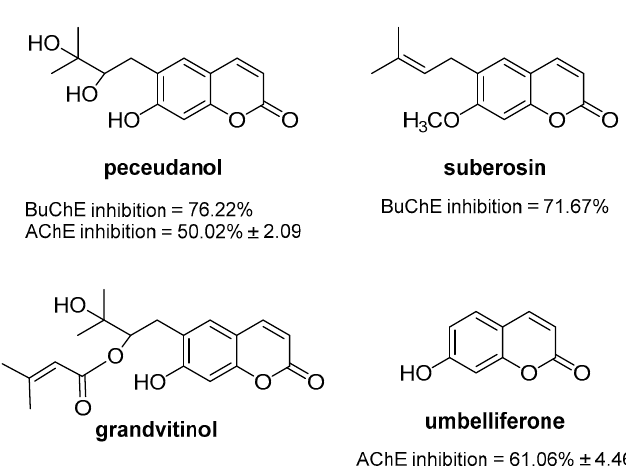
Figure 39. Coumarins extracted from Ferulago cassia.